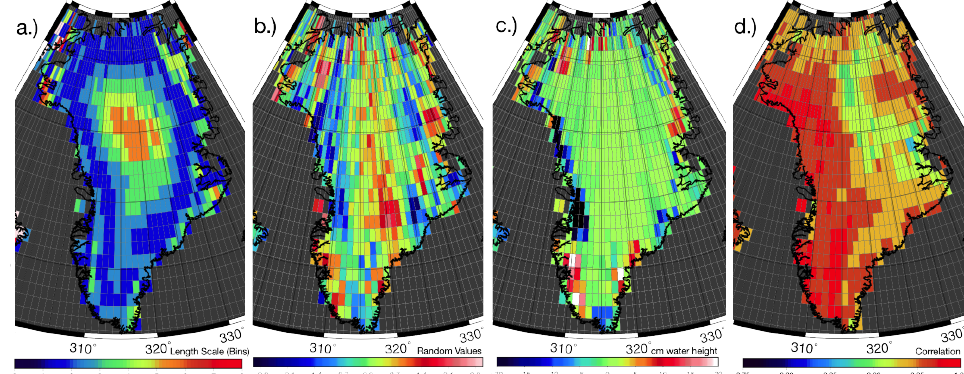
Figure 3. Example components of the simulation-building process: (a) the typical RACMO2 length scales as defined by the trend and climatology; an example of the random part of the trend signal made using this spatially correlated randomization, before (b) and after (c) applying the RMS-based amplitude weighting; and (d) the 1-month-lag autocorrelation of the RACMO2 residuals, used for the time component of the interannual and subannual simulation